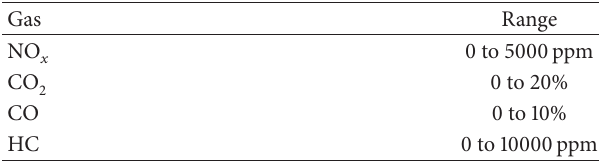
Table 3: Range of Crypton EN290 series gas analyser.